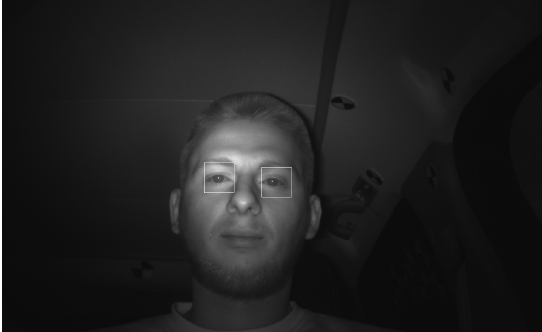
Figure 8. Result of the eye selection